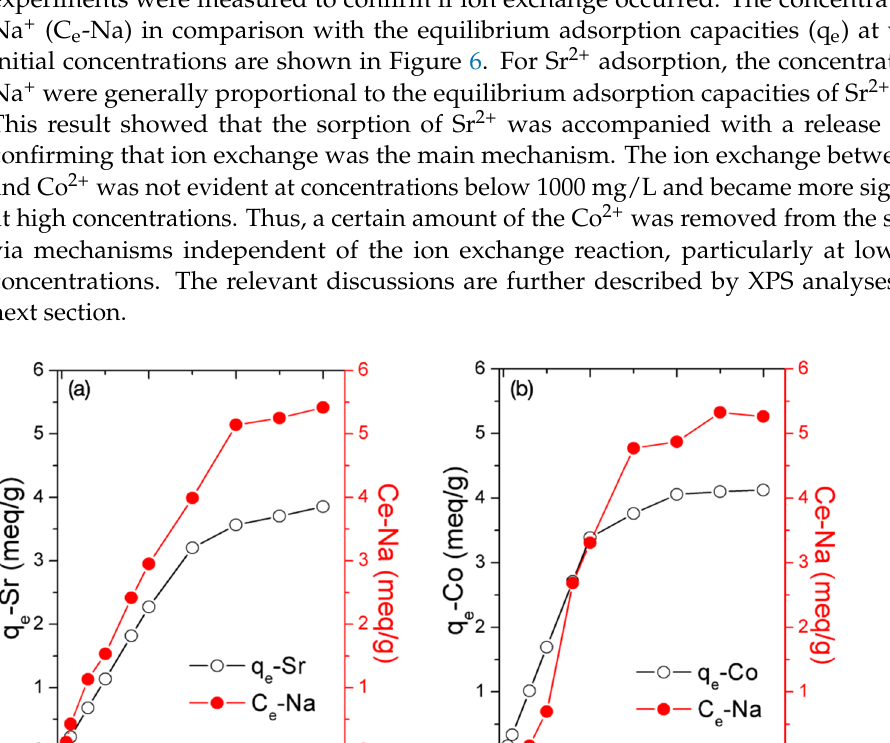
9 of 14 Table 3. Kinetic adsorption parameters of BK3 by PFO and PSO models. Concentration Sr 2+ Co 2+ k q e R 2 k q e R 2 Pseudo-First-Order Model (PFO) 1000 mg/L